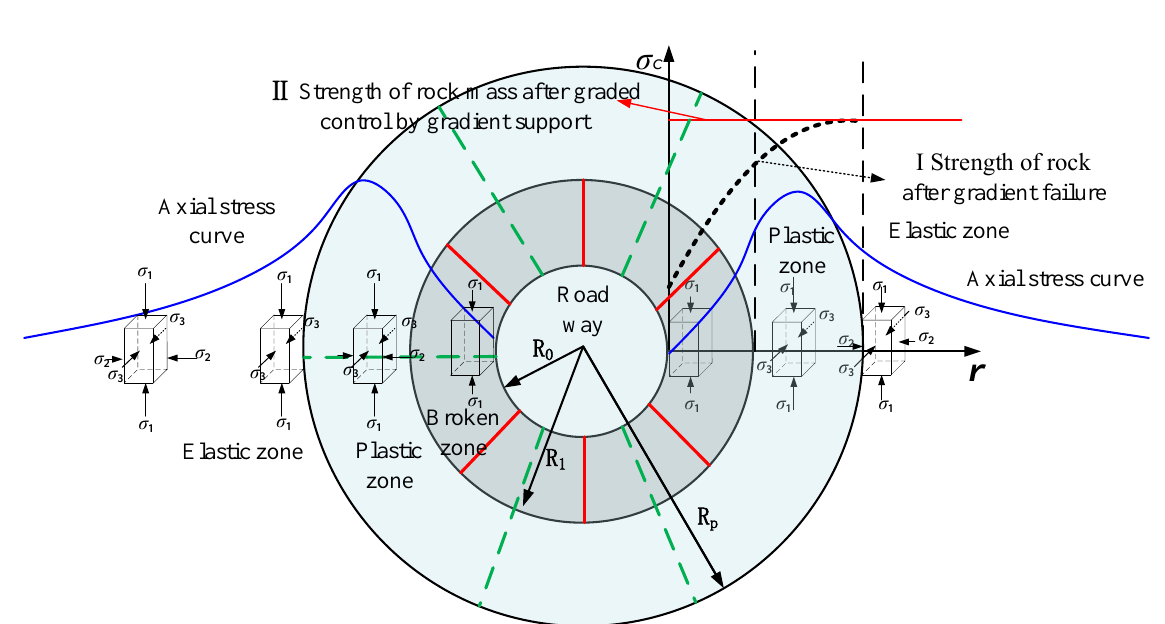
Figure 5. Mechanical model of graded support control.